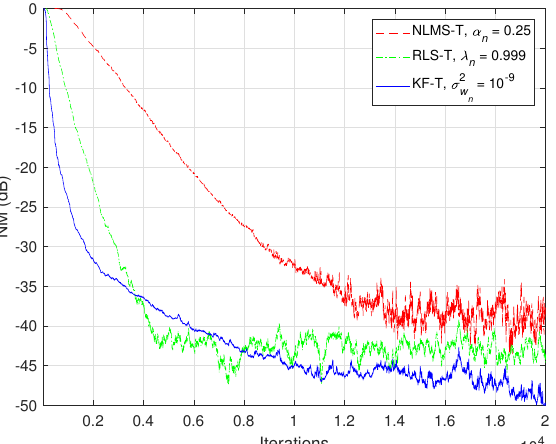
Figure 9. Normalized misalignment (NM) of the NLMS-T algorithm using α n = 0.25, n = 1,2, . . . , N , the RLS-T algorithm using λ n = 0.999, n = 1,2, . . . , N , and the KF-T using σ 2 w 1,2, . . . , N , for the identification of the global impulse response, h ( t )